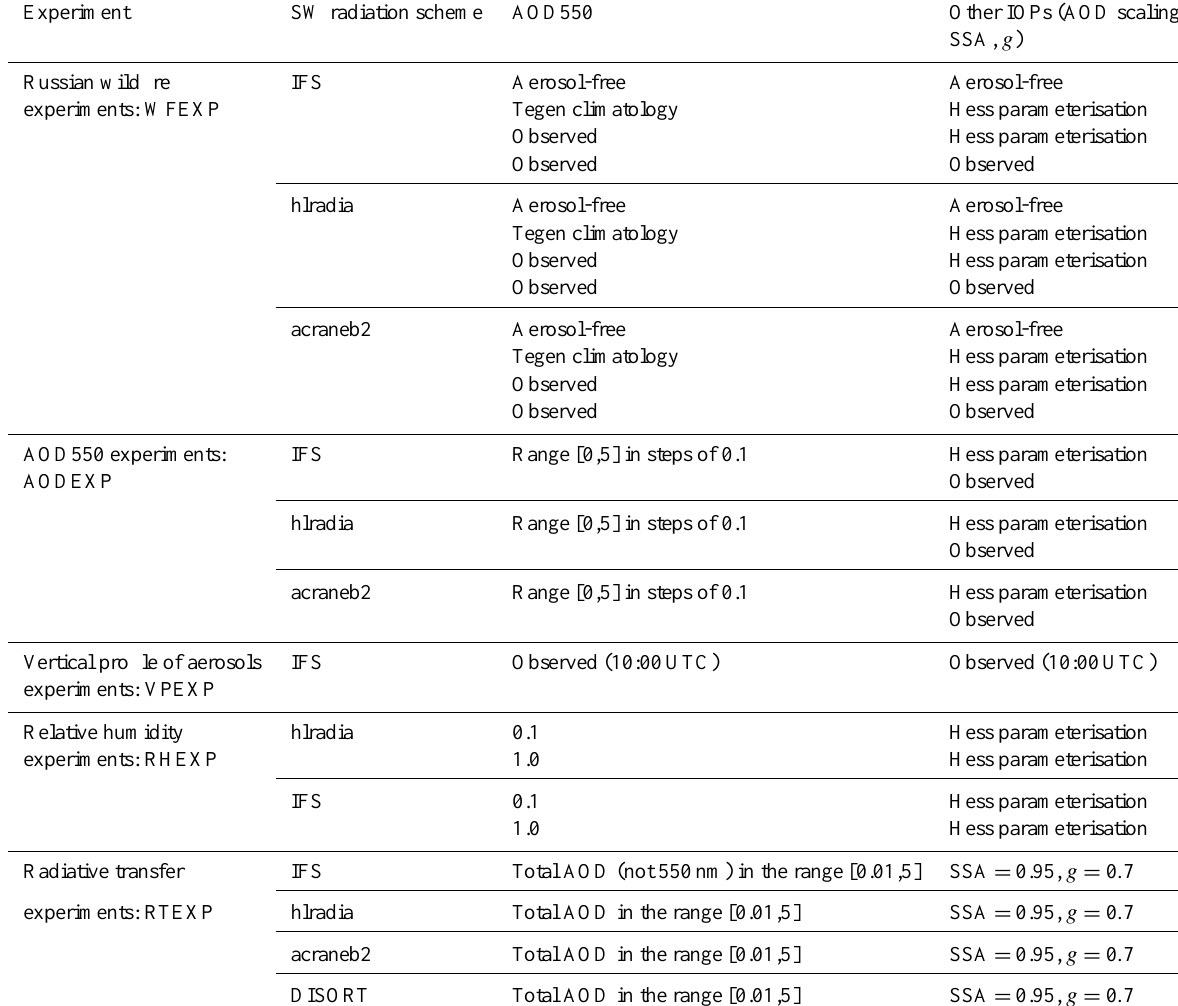
Table 2. Summary of aerosol radiation experiments including details of the radiation schemes and aerosol data sets